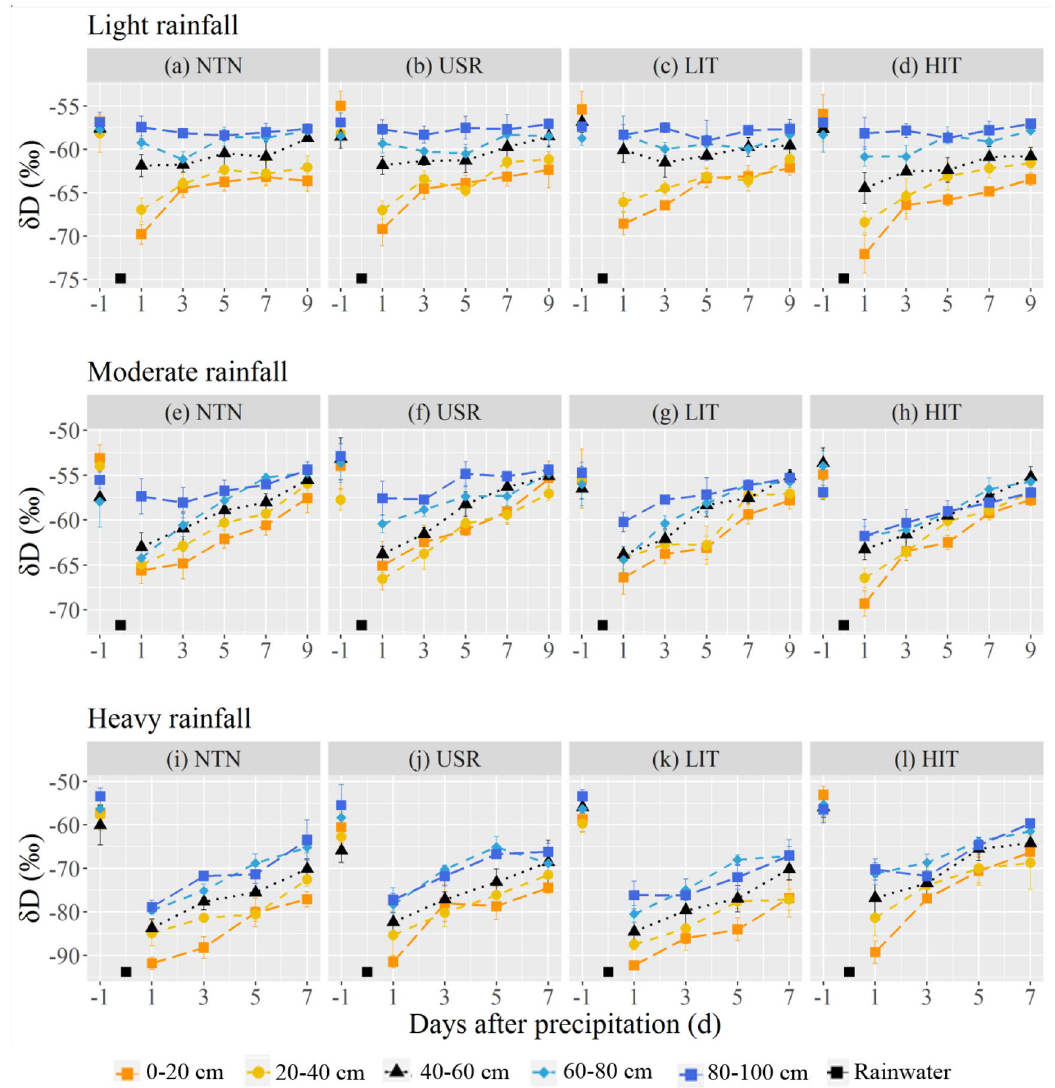
Figure 3. Daily δ D of rainwater and soil water of the P. massoniana stands with no thinning (NTN, a,e,i ), understory removal (USR, b,f,j ), light-intensity thinning (LIT, c,g,k ) and heavy-intensity thinning (HIT, d,h,l ) before and after the three rainfall events.